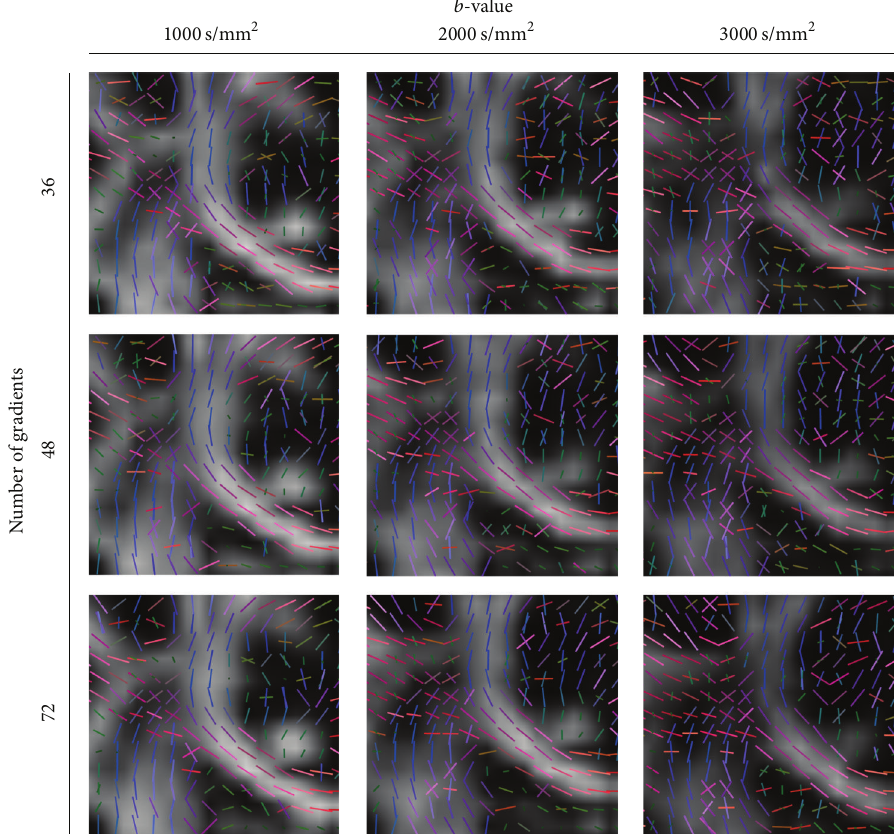
Figure 13: The effect of the 𝑏 -value and the number of gradients at 𝑙 = 4 , maxima representation. Conclusions are the same as in Figure 12.